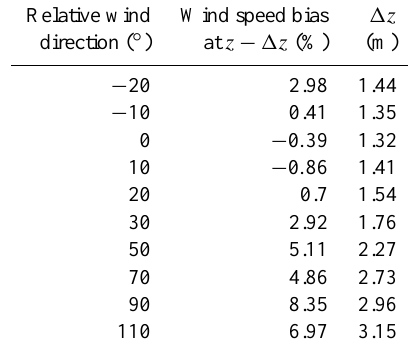
Table B1. Variation of wind speed bias and vertical flow displace- ment with relative wind direction, determined at the location of the AutoFlux anemometer (height above sea level, z , 16.5m). The wind speed bias and (cid:49)z are relative to a free stream location 2s upstream of the anemometer site (after Yelland et al., 2002). A negative rela- tive wind direction indicates a flow over the port side. Further details are given in Moat and Yelland